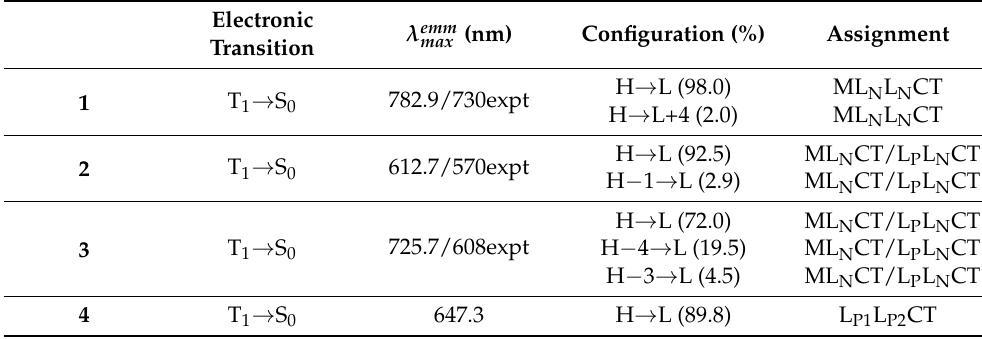
Table 4. Emission spectra obtained by the TDDFT method in CH 2 Cl 2 for studied complexes, together with experimental values. Electronic λ emm max (nm) Configuration (%) Transition